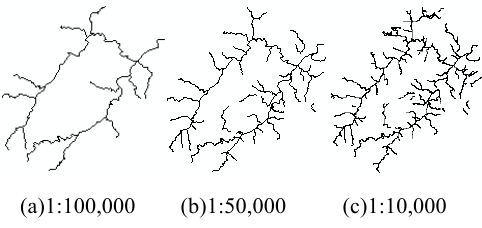
Figure 5: The result of